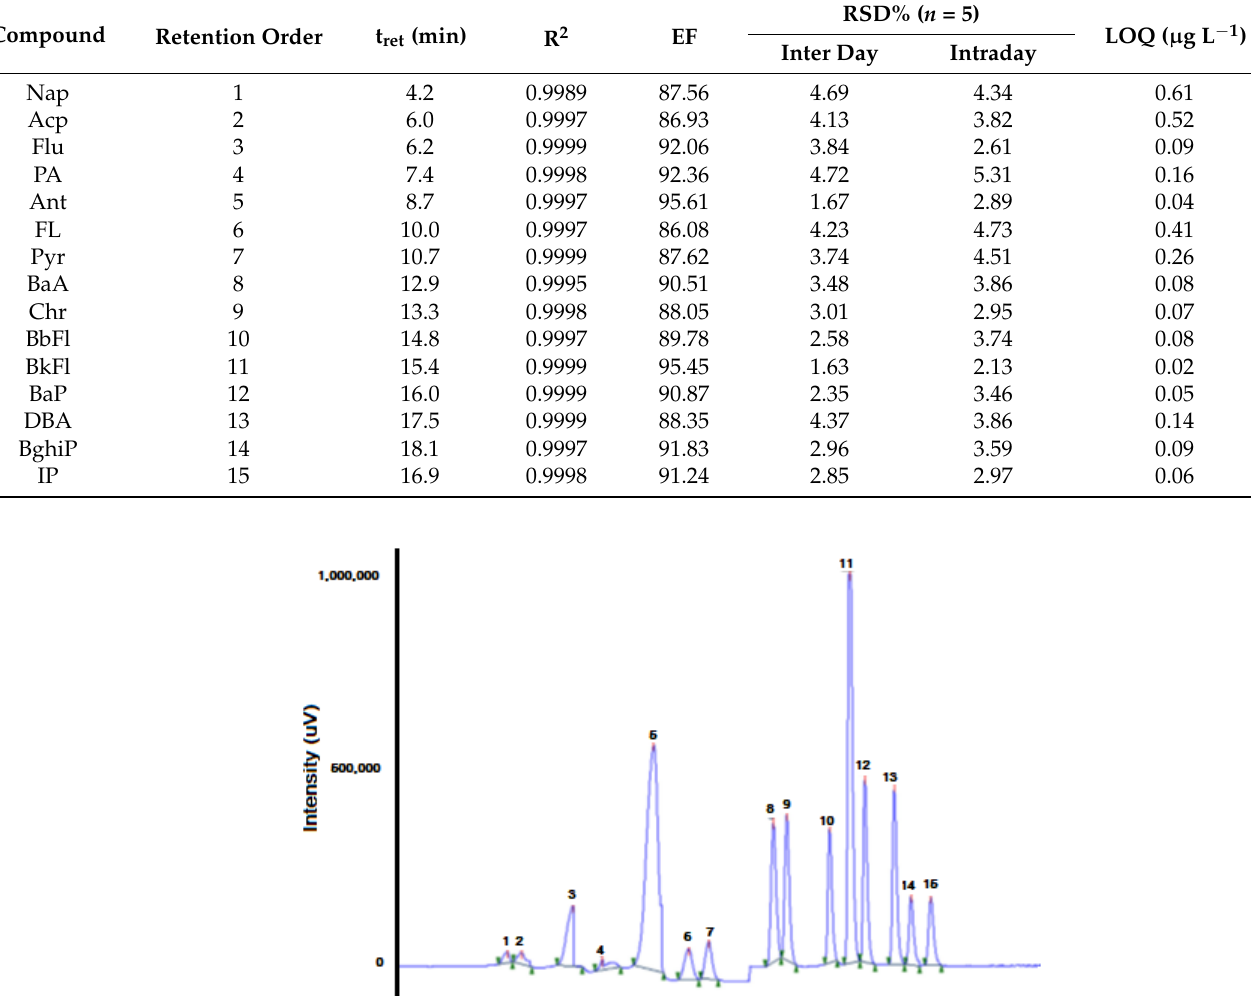
Table 3. PAHs: Retention times, variation coefficient, enrichment factor, reproducibility of the method, limits of detection.